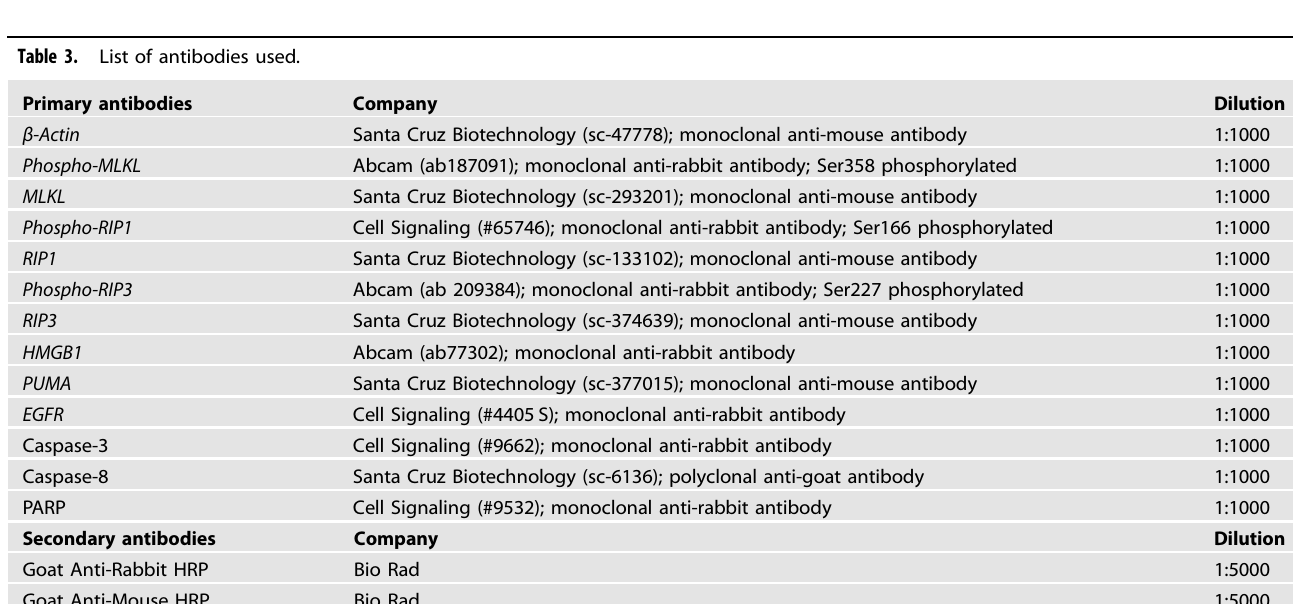
Secondary antibodies Company Goat Anti-Rabbit HRP Goat Anti-Mouse